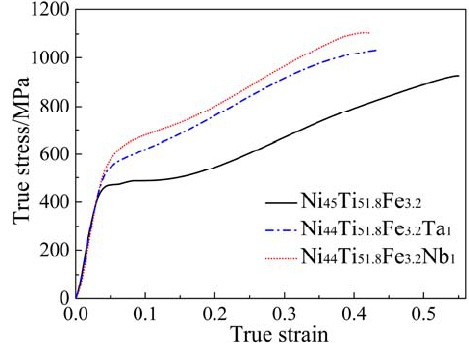
Figure 6. Compressive stress-strain curves of the three NiTi-based SMAs.